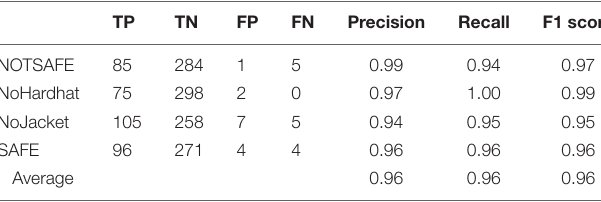
TABLE 3 | Classification report for the validation set.